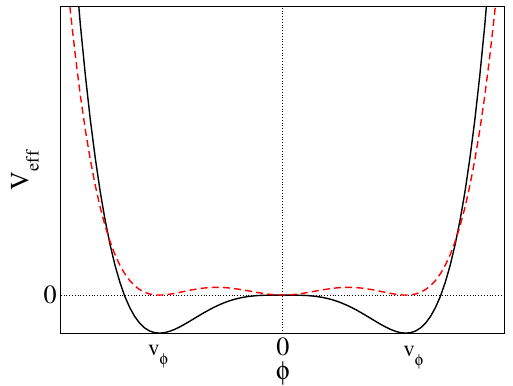
Figure 1 . Shape of the Z 0 invariant scalar potential at the CP 1-1 (solid) and the CP 1-2 2